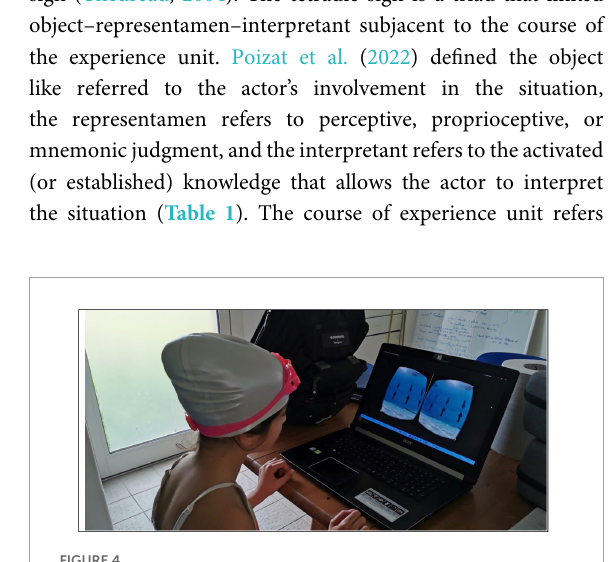
FIGURE4 Self-confrontation with swimmer during lap-top